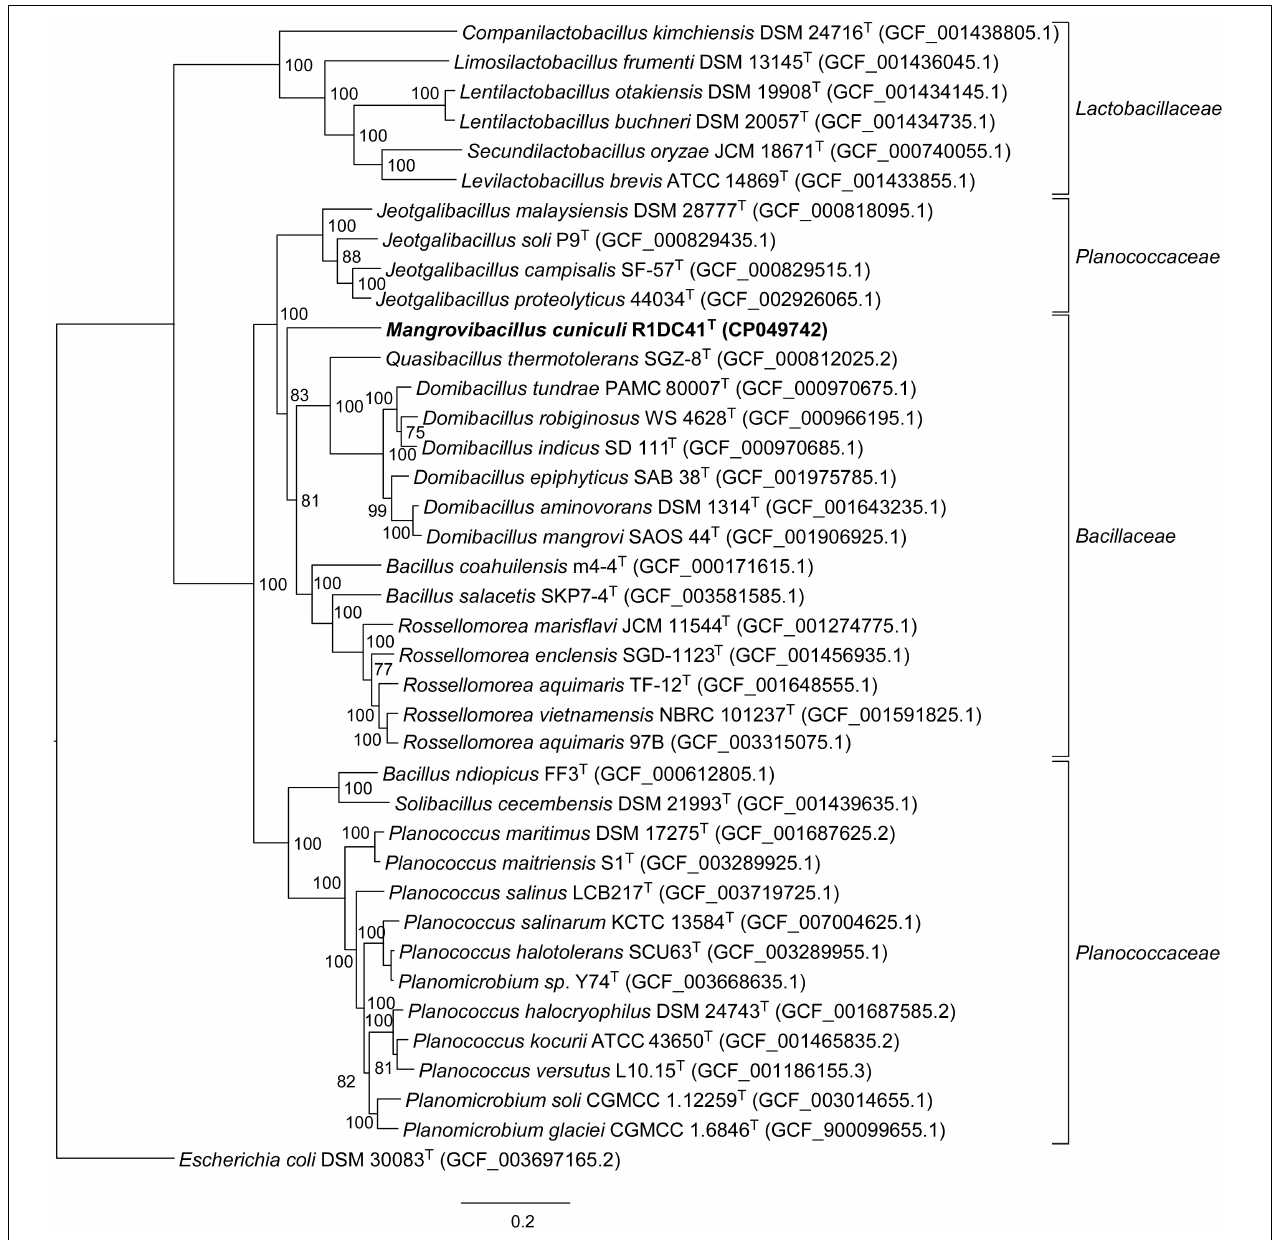
FIGURE 3 | MLSA phylogenetic tree, based on the neighbor-joining algorithm, of R1DC41 T strain, and other closely related members of the family Bacillaceae , Lactobacillaceae , and Planococcaceae based on 120 concatenated single-copy genes reconstructed using the GTDB-Tk software. Bootstrap values based on 1,000 replications are listed as percentages at branch points. Bar, 0.2 nt substitutions per nucleotide